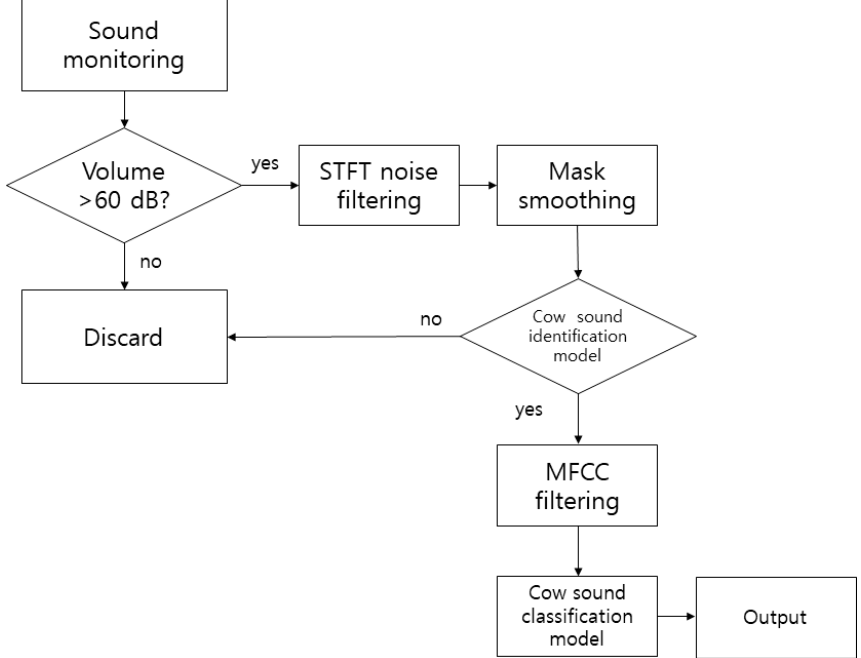
Figure 2. Flow chart of the audio data collection and noise filtering in the on-site monitoring system.